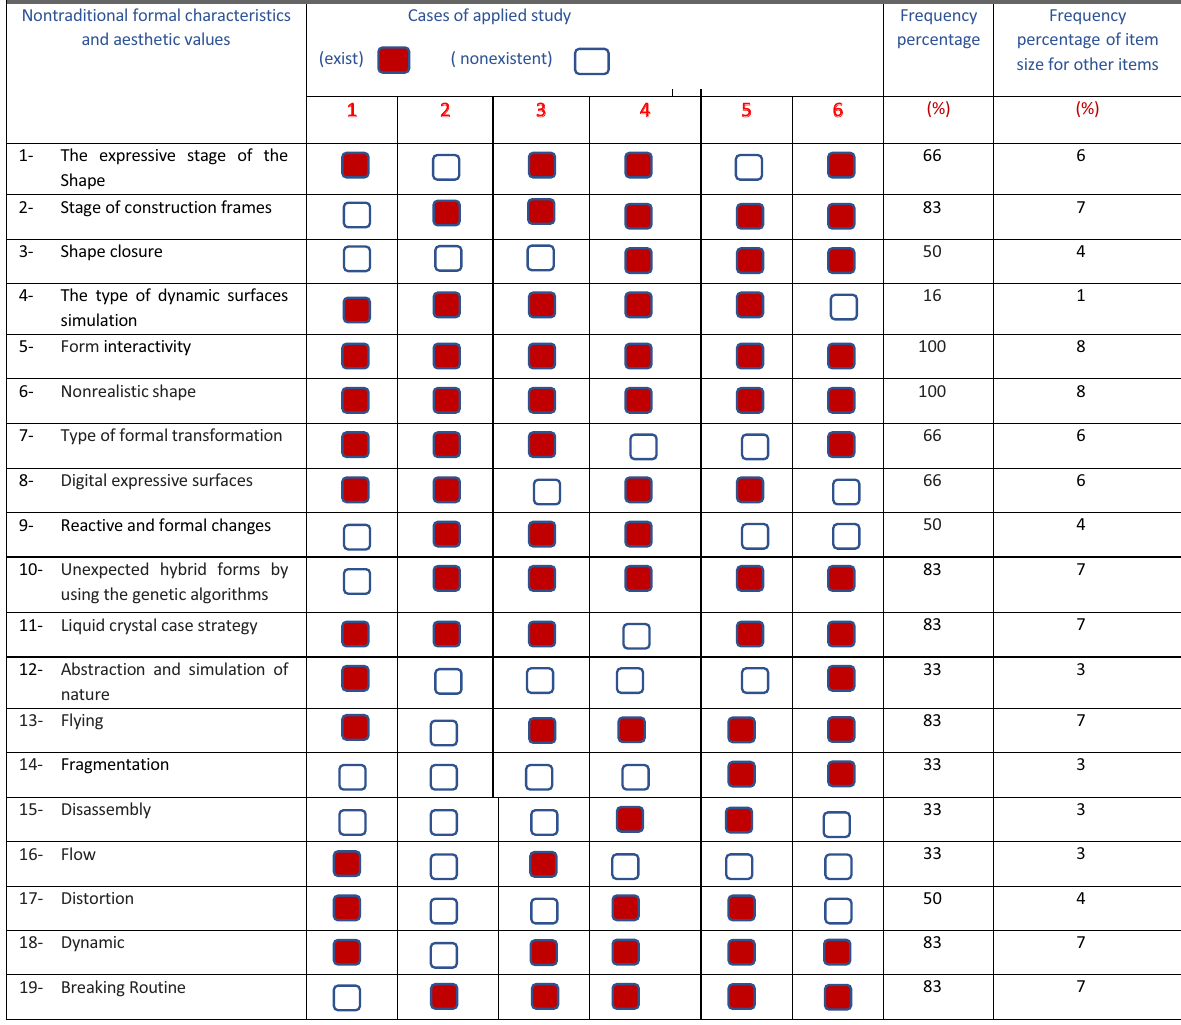
Table 3 The matrix of formal characteristics and non-traditional digital esthetic values extracted from previous studies and applying to the selected study cases. Source : the researcher Nontraditional formalcharacteristics and aesthetic